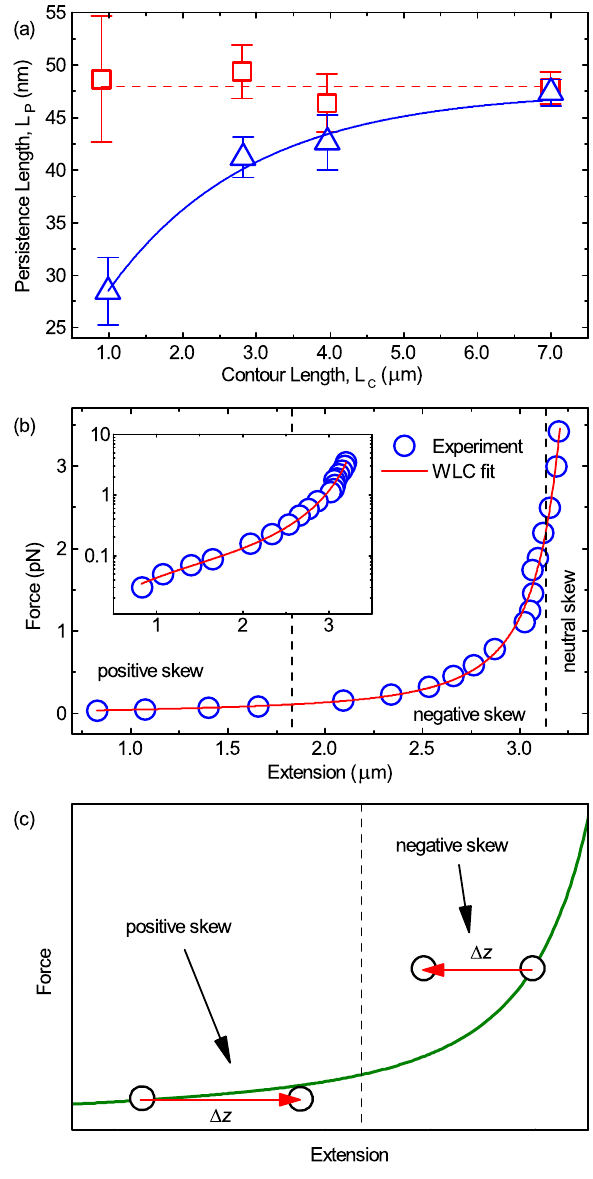
Figure 7. Representative fit of force versus extension data and the deduced L P . (a) Experimental uncorrected results (blue triangles) showing the variation of persistence length, L P , as a function of contour length, L C , shows a pronounced and statistically significant decrease for shorter DNA constructs. Following the correction procedure in the text a corrected L P is obtained (red squares). Errors shown are standard error of the mean with n ~ 20,35,32,55 in ascending contour length. Dashed red line is L P ~ 50 nm , blue line is a guide to the eye. (b) Experimental force-extension curve with a WLC model fit (red line) for a 12 kb DNA molecule. For this case L P ~ 45 + 4 nm and L C ~ 3 : 49 + 0 : 02 m m . Inset) The same data on a log scale. (c) Diagram that illustrates the effect that a mismeasurement in microsphere position has upon DNA extension for positive and negative skew. The red arrows start at the extension measured using the arithmetic mean, m z , and end at the position expected if the skew normal distribution location position, j z , is used